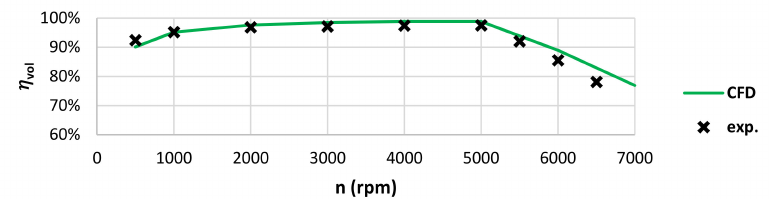
Figure 15. Volumetric efficiencies obtained from the CFD simulations and from the experiment for the IGP at 22.5 bar pressure load and 20 ◦ C oil